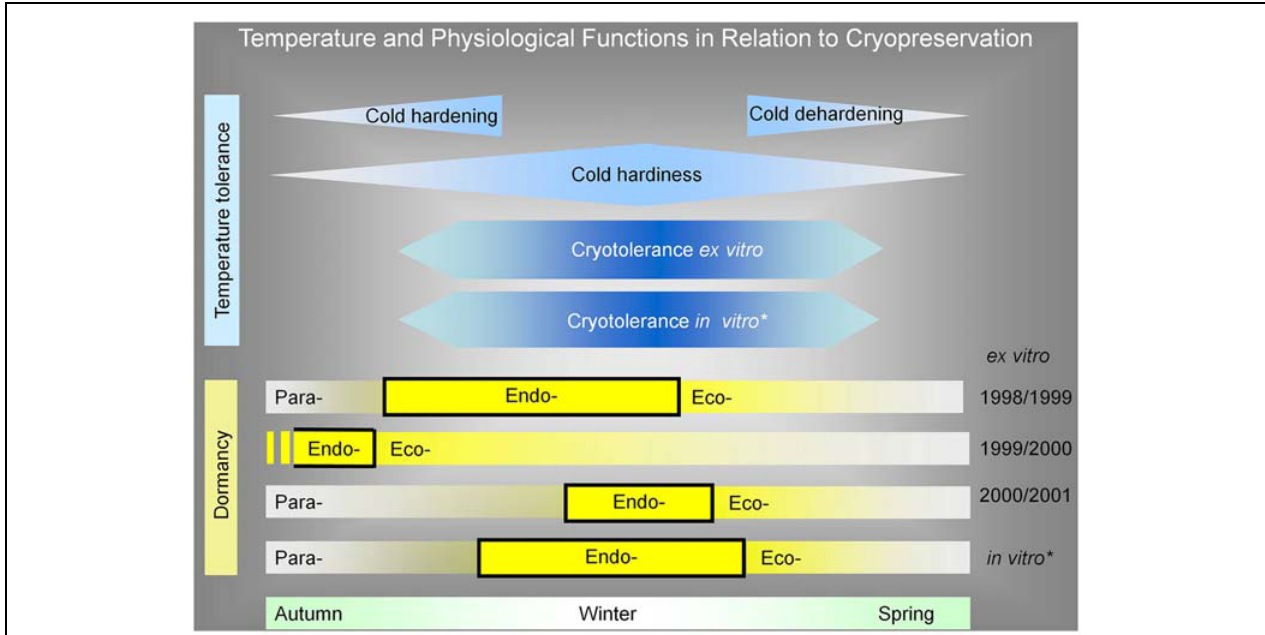
FIGURE 8 | Apple tree plant cryotolerance and cold hardiness as a reaction to low temperature in relation to its (para-, endo-, eco-) dormancy. For comparison, the cryotolerance of ex vitro over all studied seasons was unified in time. The in vitro dormancy was added in the same range as ex vitro cryotolerance range. The dormancy and its parts were added in relation to evaluated cryotolerance range. From this expression, it is evident that the cryotolerance was not dependent on endodormancy, because, e.g., in the season of 1999/2000, the endormancy ended before the cryotolerace was established. The cryopreservation method for ex vitro dormant bud plants was two-step freezing, with pretreatment at –5 ◦ C for 2 months. The cryopreservation method for plants from in vitro was encapsulation/dehydration, without any pretreatment. The cryotolerance of ex vitro plants was determined after the immersion of buds in LN as a regrowth of new shoot from buds grafted on rootstock. The cryotolerance of in vitro plants was determined as new shoot regrowth in in vitro conditions. ∗ Bilavcik et al.